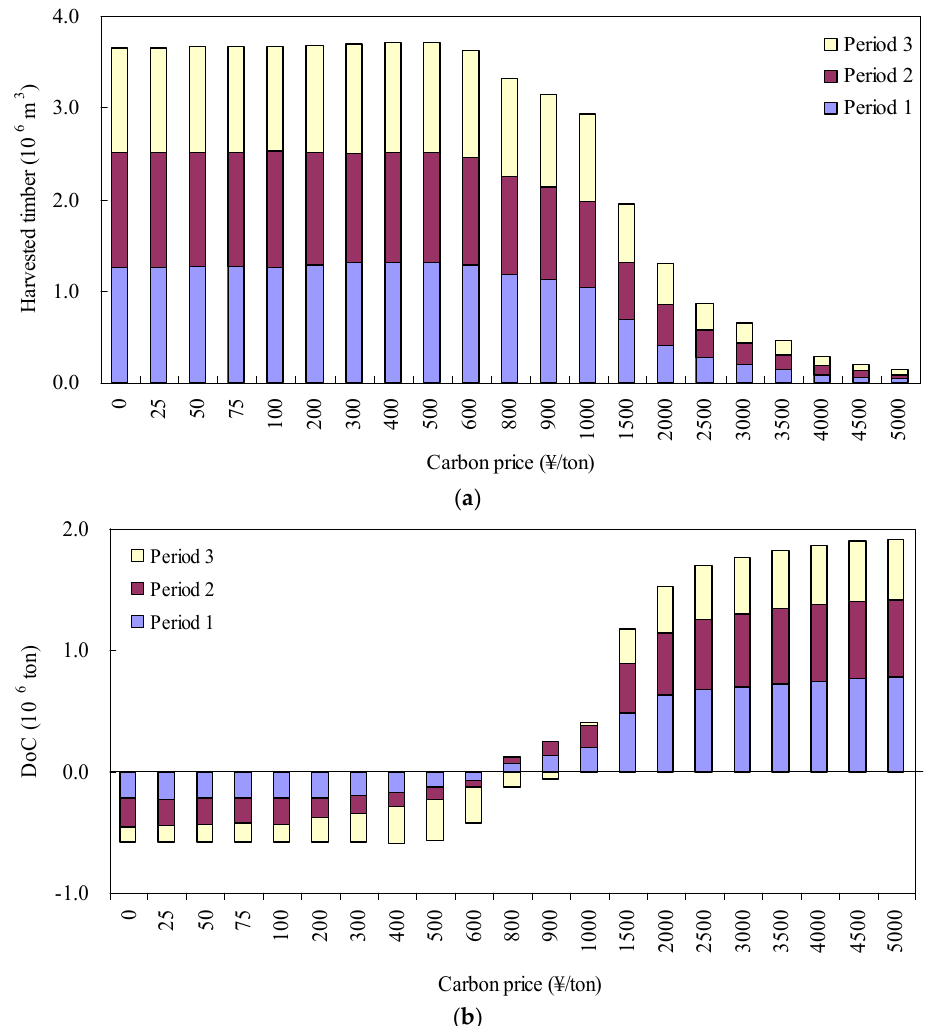
Figure 4. Levels of harvested timber ( a ) and the DoC ( b ) for each time period when carbon prices varied from zero to 5000 ¥/ton, where DoC represents the differences of carbon stocks in living tree biomass between the beginning and end of the planning horizon.